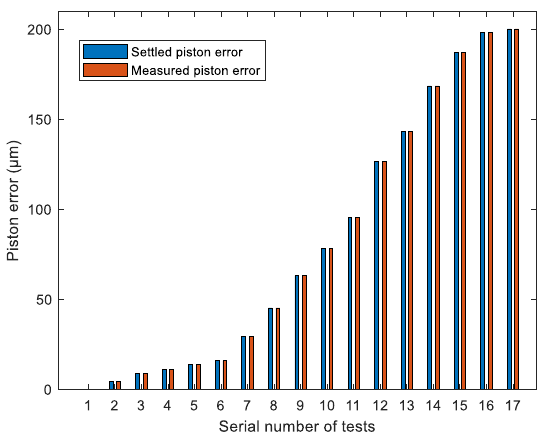
Figure 7. The piston error detection results in bar chart form for two segments system with a BP artificial neural network. artificial neural network.